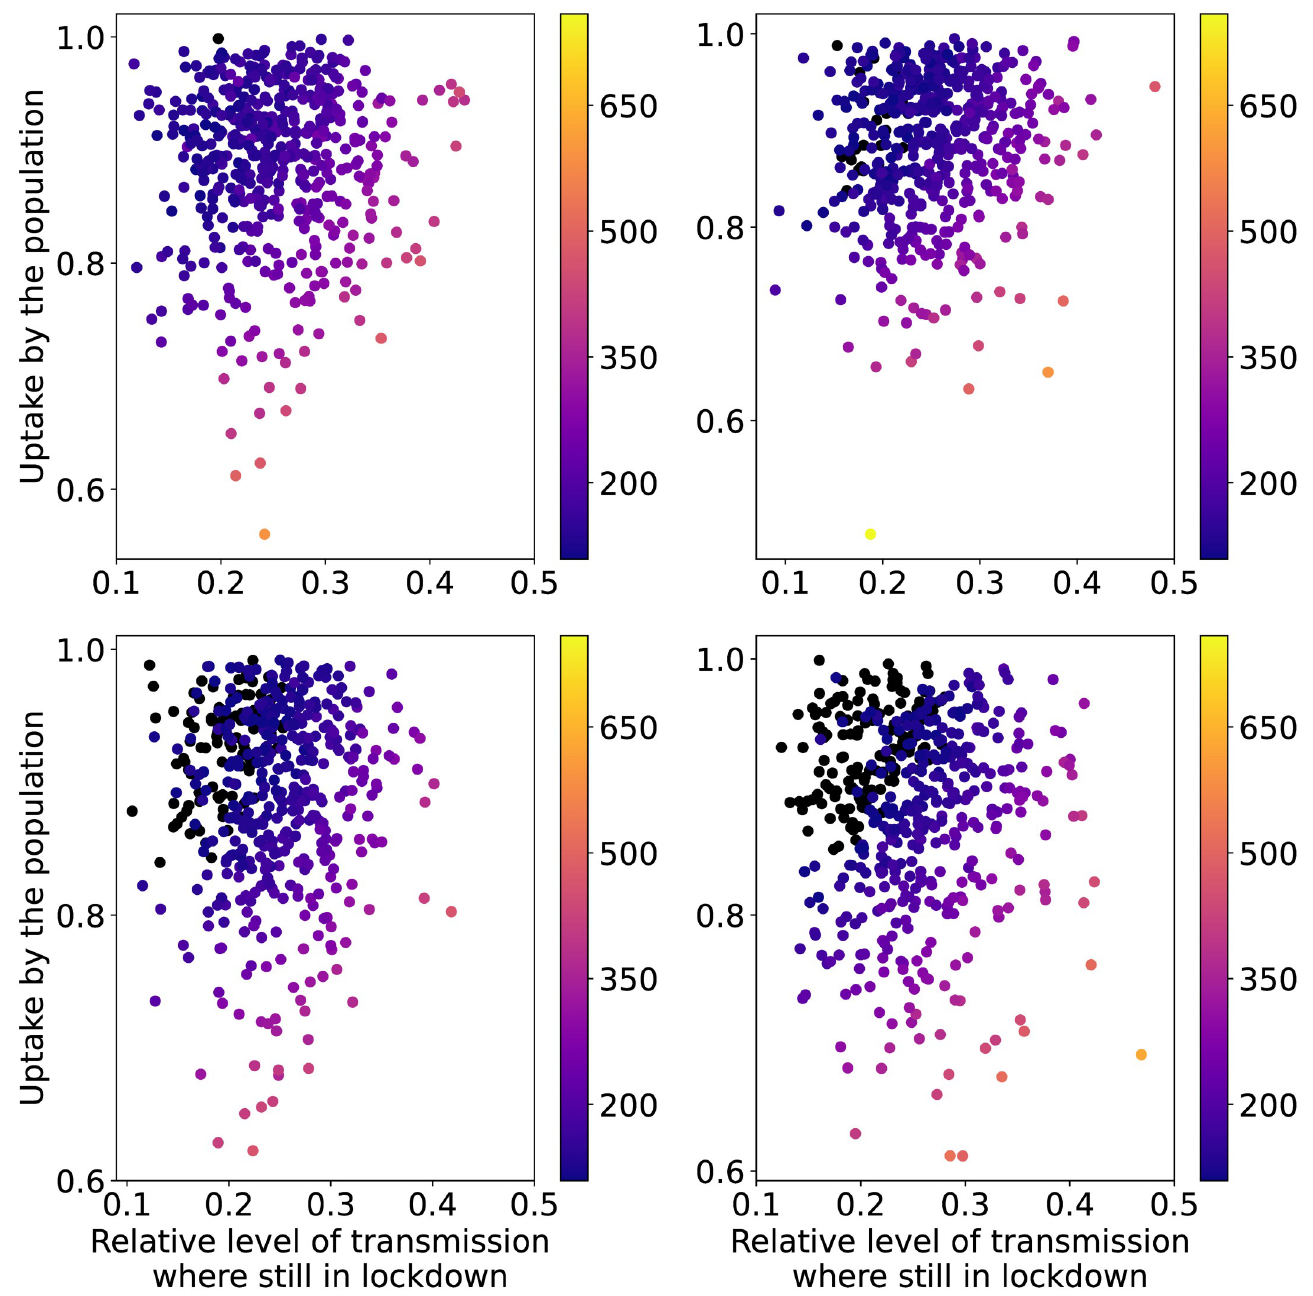
Fig 7. Heat map of the maximum values of patients in IC per million capita as a function of the input parameters for the PO strategy with seed and policy- related uncertainties. The black dots show the simulations whose maximum value is below or equal to the IC capacity. The plots correspond to quartiles (top left: very low; top right: low; bottom left: high; bottom right: very high) of intervention_lift_interval .